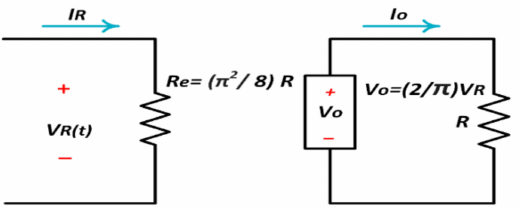
Figure 22. DR equivalent circuit with inductive output filter